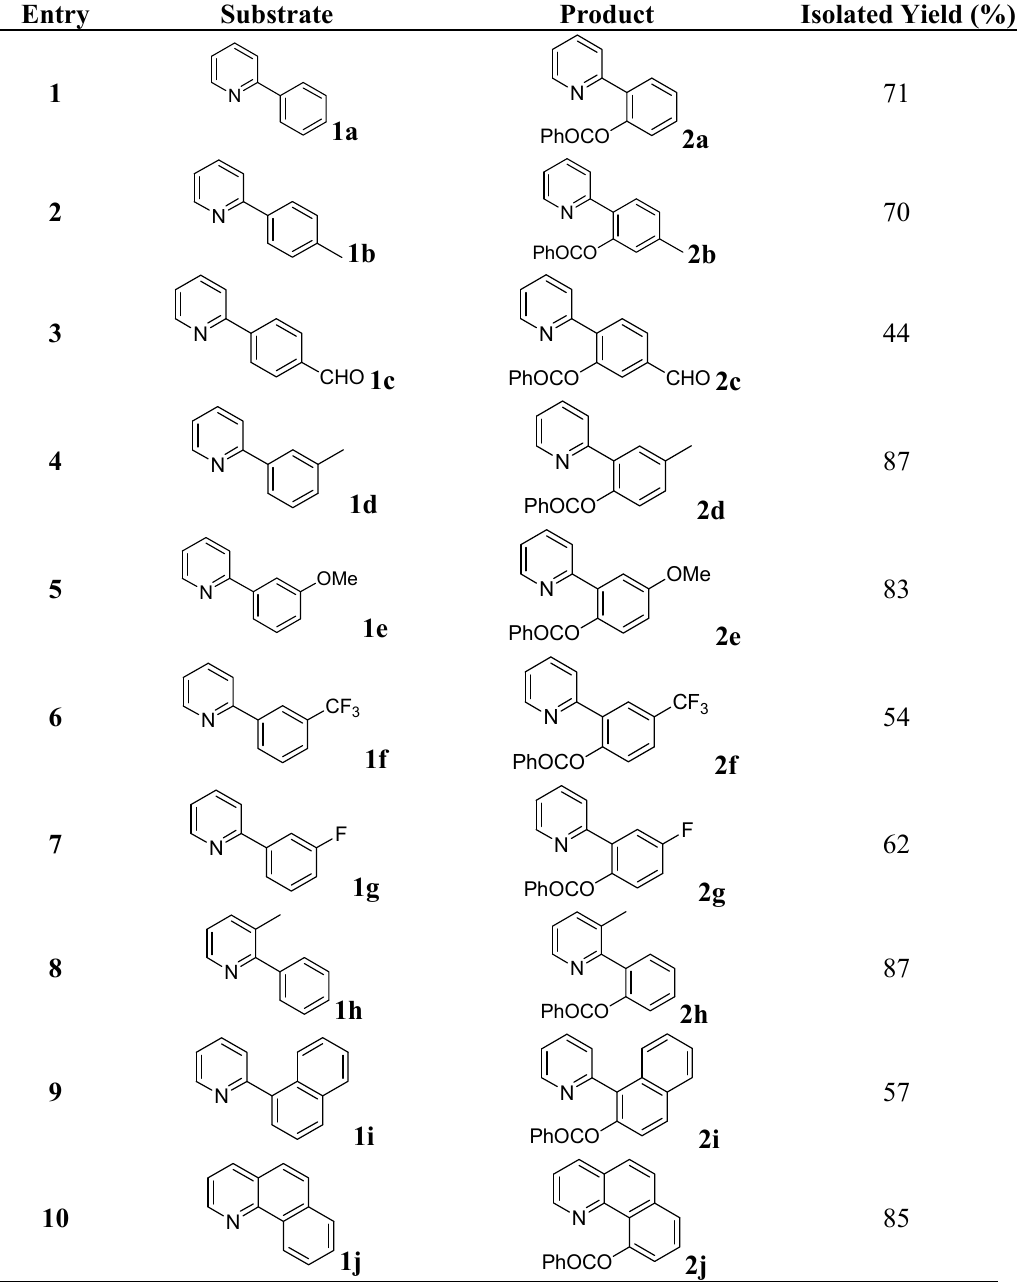
Table 3. Pd-catalyzed benzoxylation of arylpyridines a